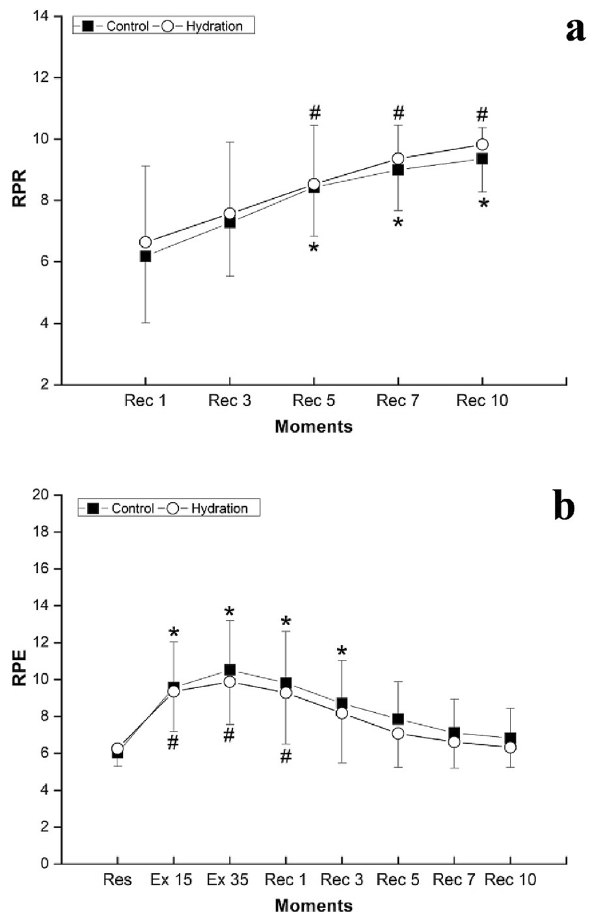
Figure 3. Mean and standard deviation for the rate of perceived recovery ( a ) and exertion ( b ) scale in both protocols. Legend: Rec 1 = 1st minute of recovery; Rec 3 = 3rd minute of recovery; Rec 5 = 5th minute of recovery; Rec 7 = 7th minute of recovery; Rec 10 = 10th minute of recovery; Res = initial rest; Ex 15 = 15th of treadmill exercise; Ex 35 = 35th minute of treadmill exercise; RPR rate of perceived recovery; RPE rate of perceived exertion. *Difference between Rec 1 and other moments of recovery ( a )/initial rest and recovery ( b ) of control protocol ( p value < 0.001); #Difference between Rec 1 and other moments of recovery ( a )/initial rest and recovery ( b ) of hydration protocol ( p value <